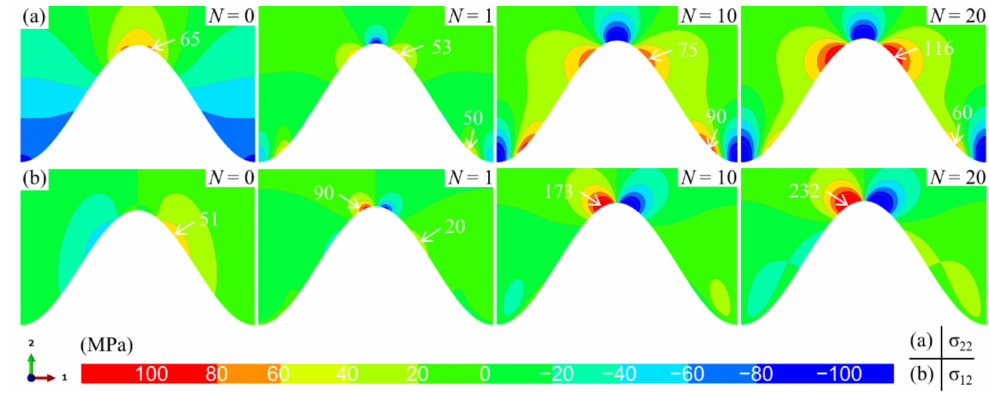
Figure 5. The stress distribution characteristic near the TC/BC interface without a bulge (at room temperature): ( a ) the normal stress σ 22 and ( b ) the shear stress σ 12 .